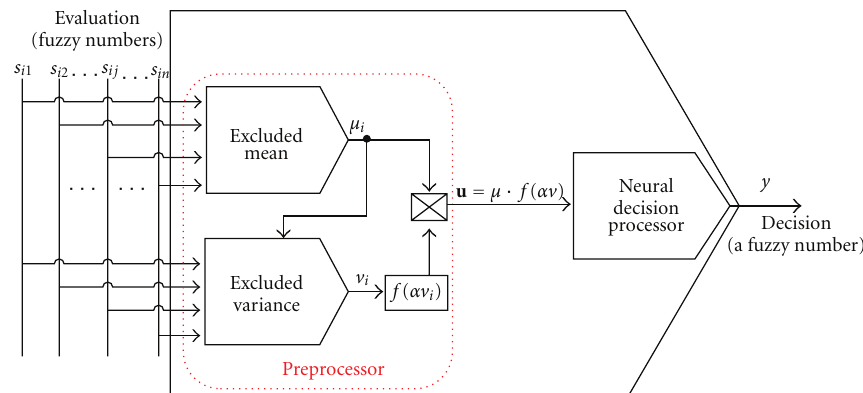
Figure 4: Schematic diagram of the preprocessor for E-MVNDA.